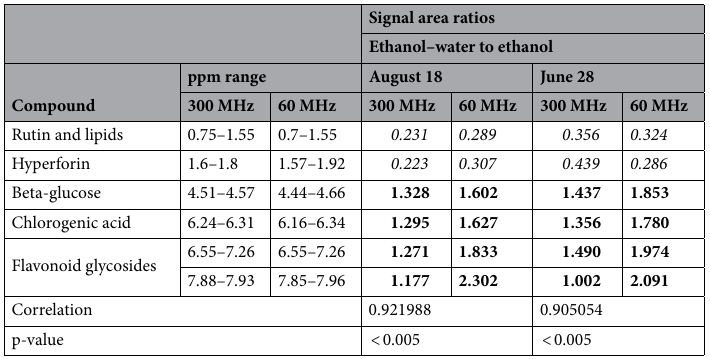
Table 2. Comparison of signal area ratio changes measured on 300 MHz and 60 MHz instruments. Increasing and decreasing signals highlighted in bold and italics